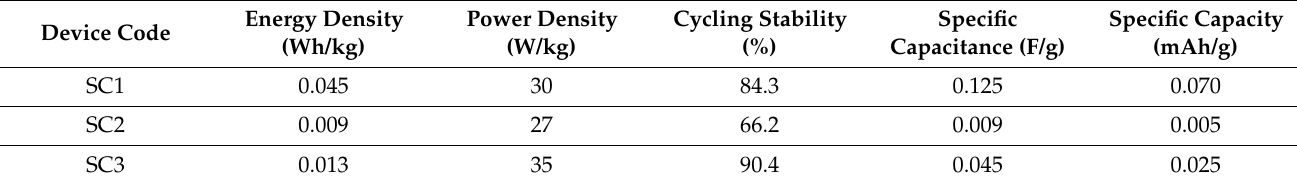
Table 2. Summary of the electrochemical performance of the fabricated symmetric and asymmetric supercapacitor devices. The cycling stability, specific capacitance and specific capacity were calculated after 50 cycles at a current density of 0.15 A.g − 1